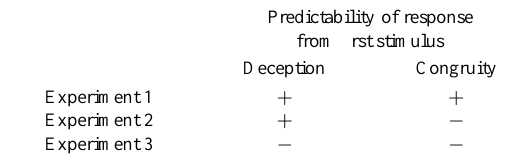
Table 1 First stimulus cues for response type (deceptive, truthful, congruent, incongruent) across the three